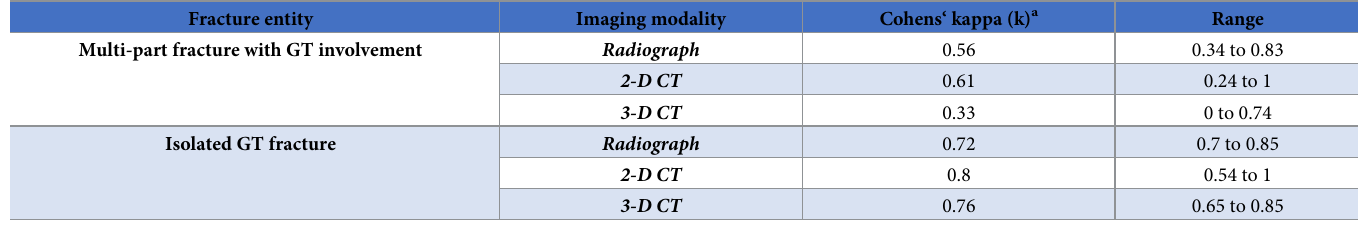
Table 2. Intraobserver reliability assessed with Cohens’ kappa (k).